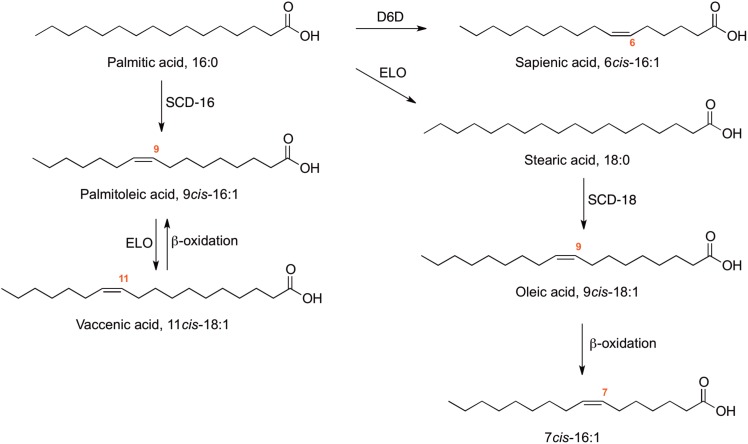
Biosynthetic pathways for the formation of three positional isomers of the hexadecenoic fatty acid family (C16 MUFA).The formation of 9cis-16:1 (palmitoleic acid) occurs from palmitic acid via delta-9 desaturase (SCD-16) and from vaccenic acid via beta-oxidation. The formation of 6cis-16:1 (sapienic acid) occurs from palmitic acid (via delta-6 desaturase, D6D) and the formation of 7cis-16:1 occurs from oleic acid via beta oxidation. Oleic acid is obtained from stearic acid (18:0) via delta-9 desaturase (SCD-18).